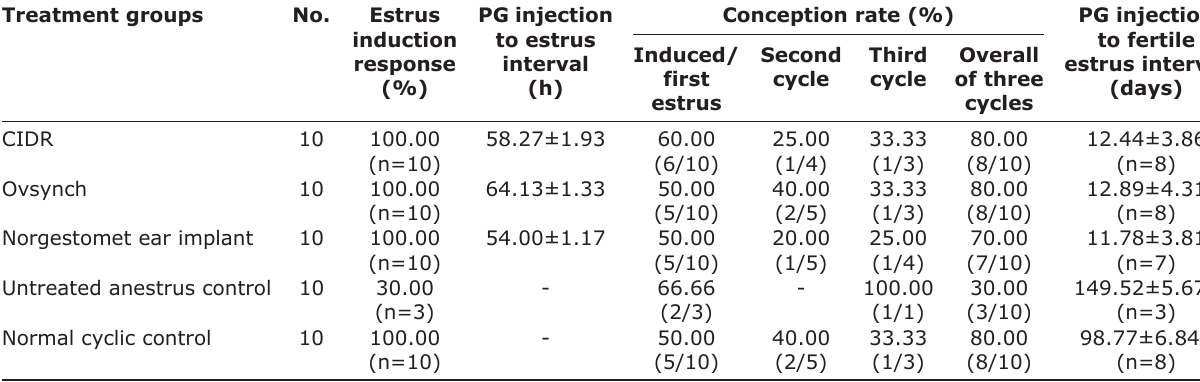
Figures in parentheses indicate number of animals/observations, *Service period/days open. PG=Prostaglandin, CIDR=Controlled internal drug